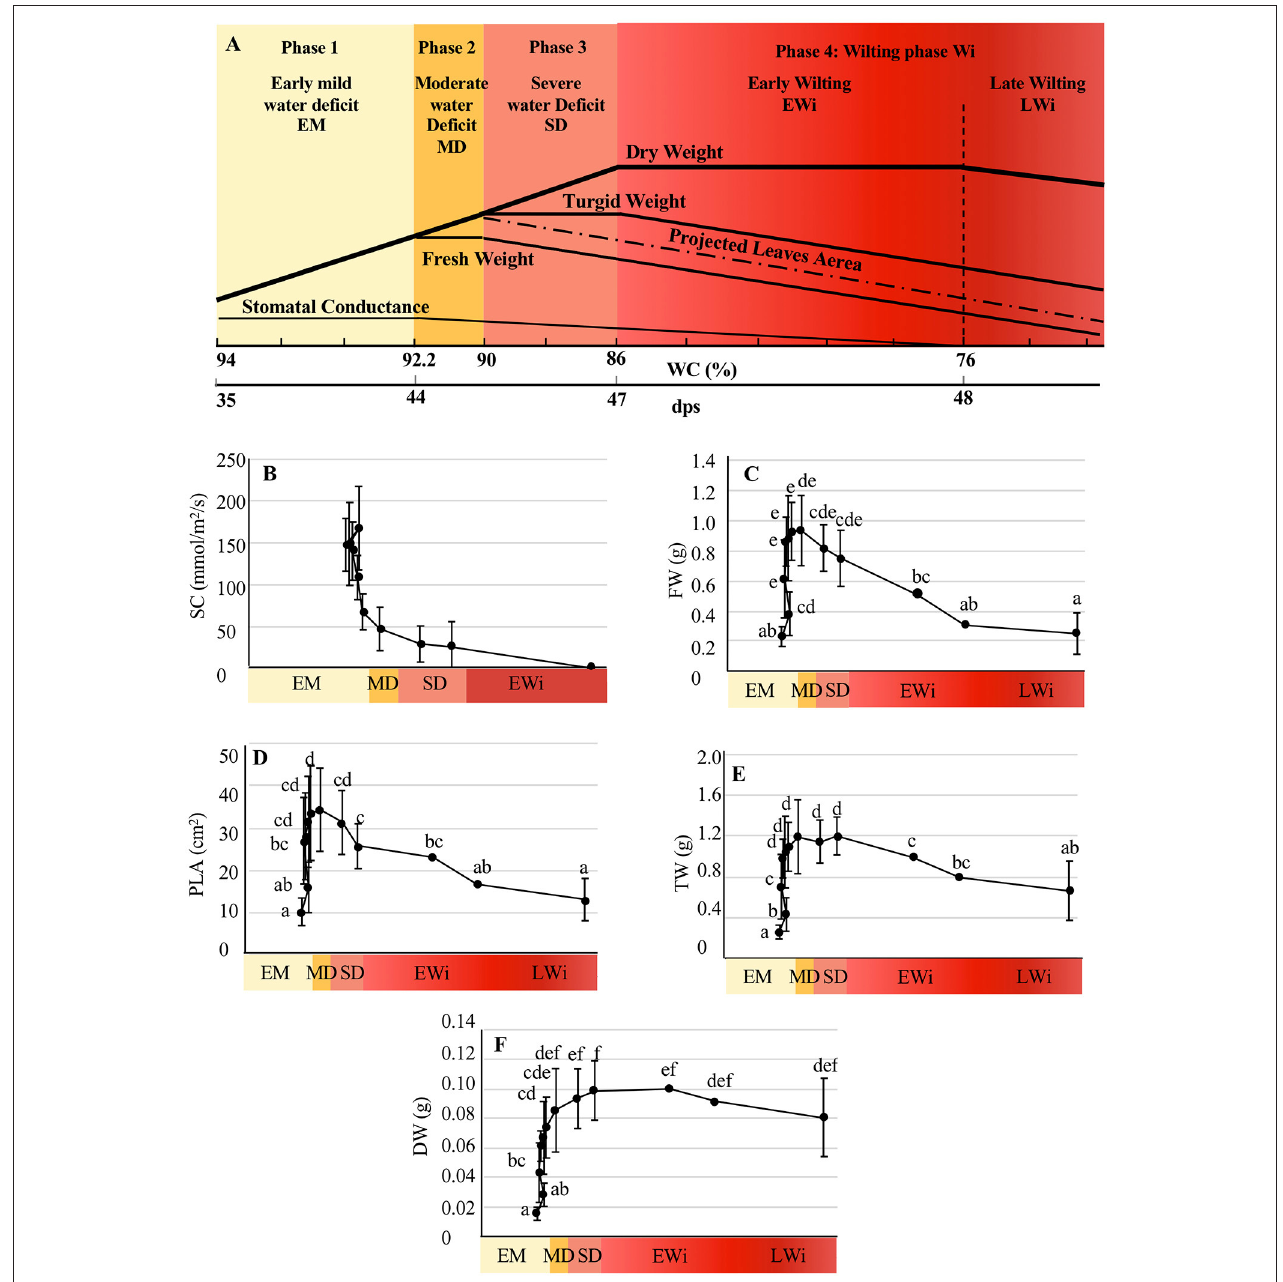
FIGURE 3 | Evolution of physiological parameters under water deficit. (A) Determination of the four phases of water deficit as a function of WC. dps, days post-sowing. Evolution of (B) SC, stomatal conductance; (C) FW, fresh weight; (D) PLA, projected leaf area (PLA); (E) TW, turgid weight; (F) DW, dry weight in WD A. thaliana Col-0 represented as function of the water-deficit phases. The study was carried out with five plants per condition, and three independent biological repeats were performed ( ± SD). Statistical analysis was performed using the Kruskal–Wallis test and multiple comparisons of Dunn ( p < 0.05) corrected by Bonferroni. Significantly different values are indicated by distinct